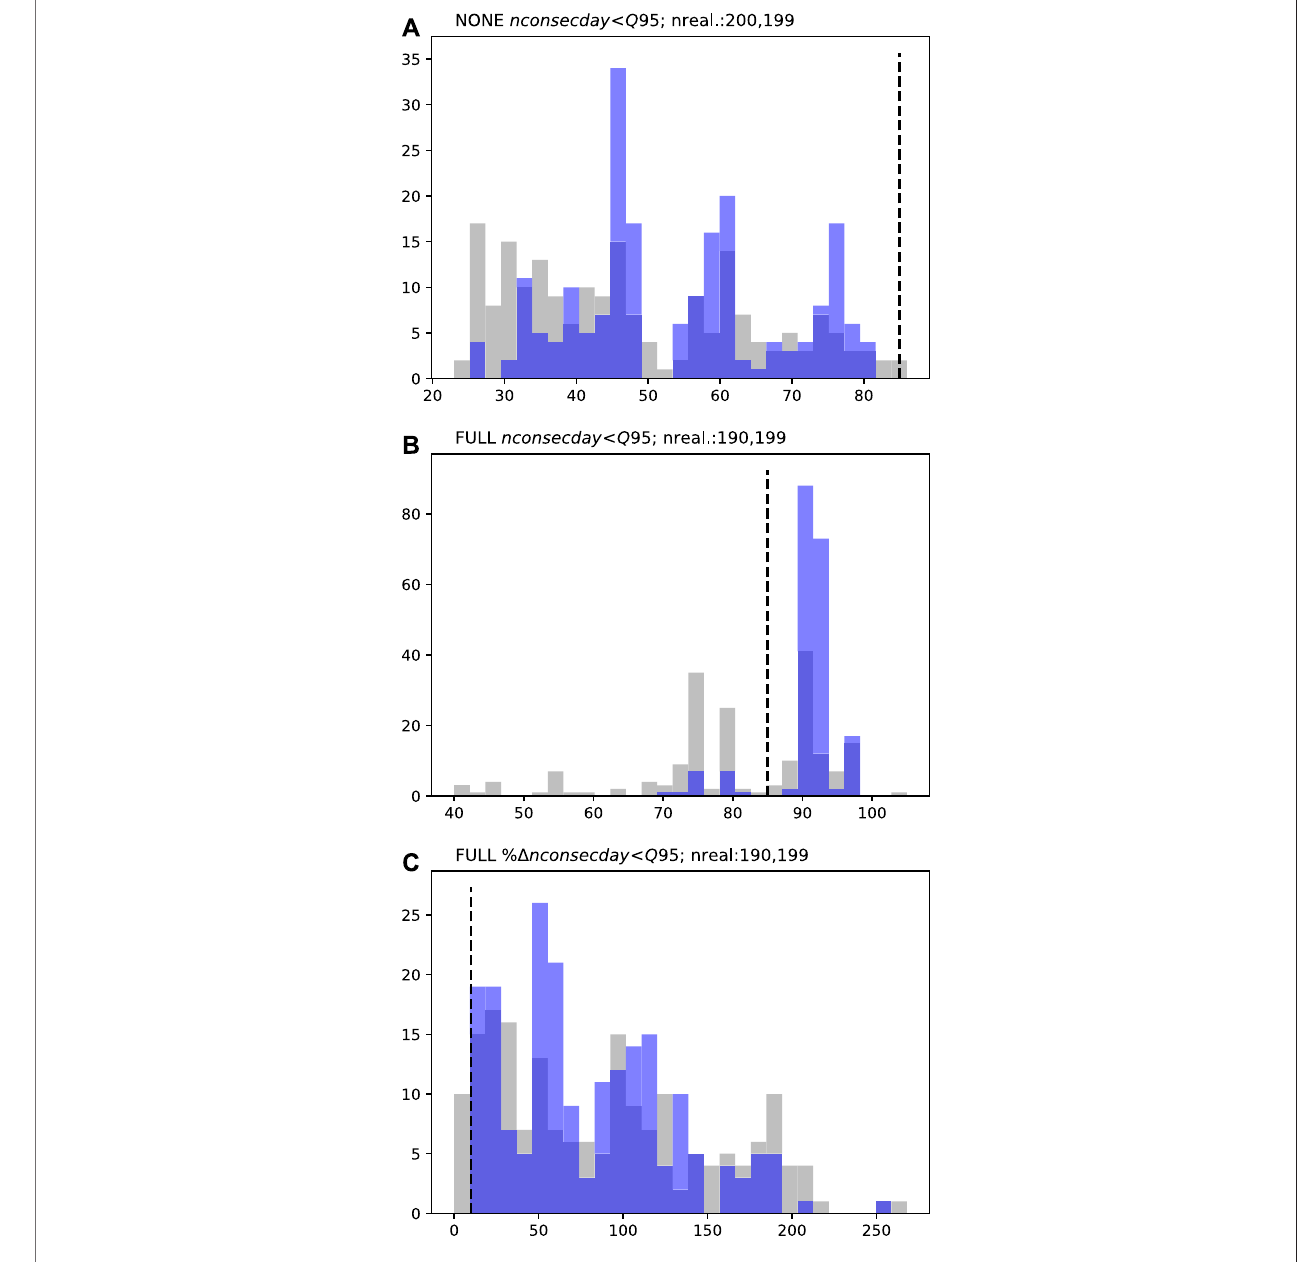
FIGURE 6 | PVW low- fl ow persistence ( nconsecday < Q95 ; A and B ) and percent change low- fl ow persistence ( %nconsecday < Q95 ; C ) prior (grey) and posterior (blue) forecast PDFs. Dashed black lines represent the respective decision thresholds (85 days in A and B and 10% change in C ). “ NONE ” represents the “ naturalized ” baselineand “ FULL ” the abstractionscenario. “ nreal. ” details the number ofsuccessful realizations (therefore the number of datapoints represented in thePDF) for prior and posterior ensembles, respectively.